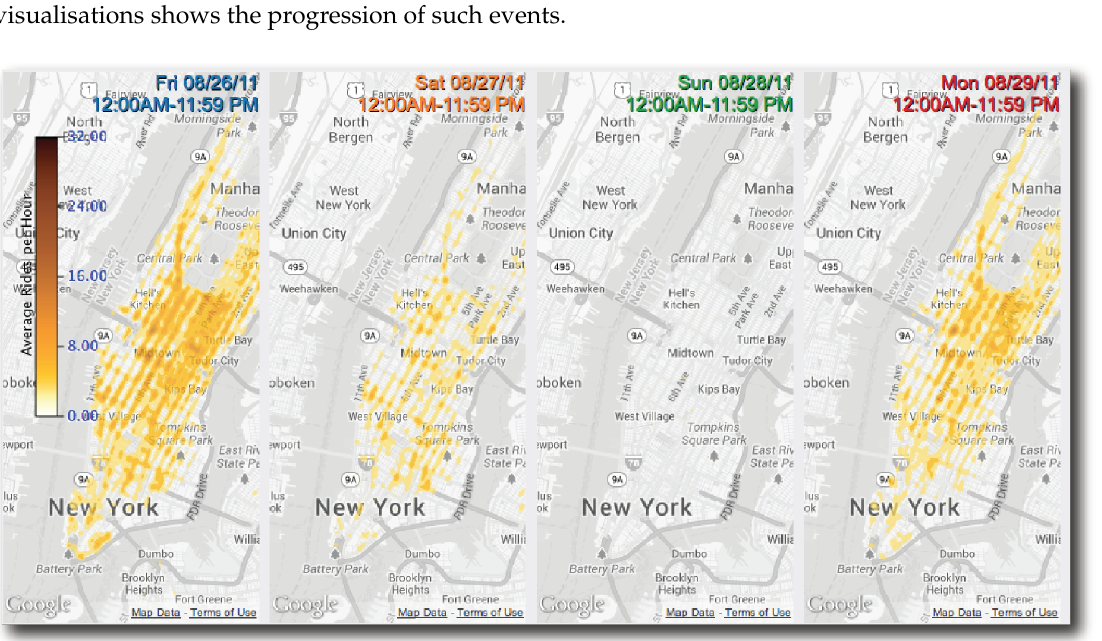
Figure 11. Taxi activity in Manhattan during the week of Hurricane Irene. Image courtesy of Ferreira et al.